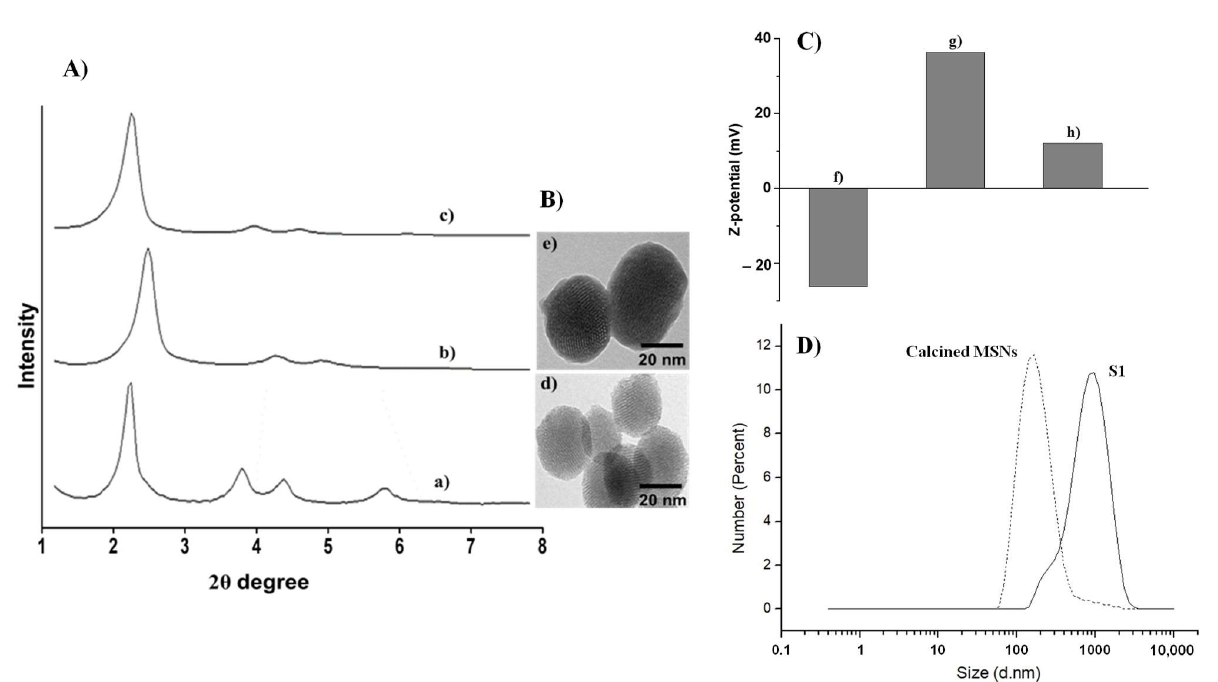
Figure 1. ( A ) Powder X-ray diffraction patterns of (a) as-synthesized MSNs, (b) calcined MSNs and (c) solid S1 . ( B ) TEM images of (d) calcined MSNs and (e) solid S1 . ( C ) Z-potential of (f) calcined MSNs, (g) amino-functionalized and loaded MSNs and (h) solid S1 . ( D ) Hydrodynamic diameter of calcined MSNs and S1 .